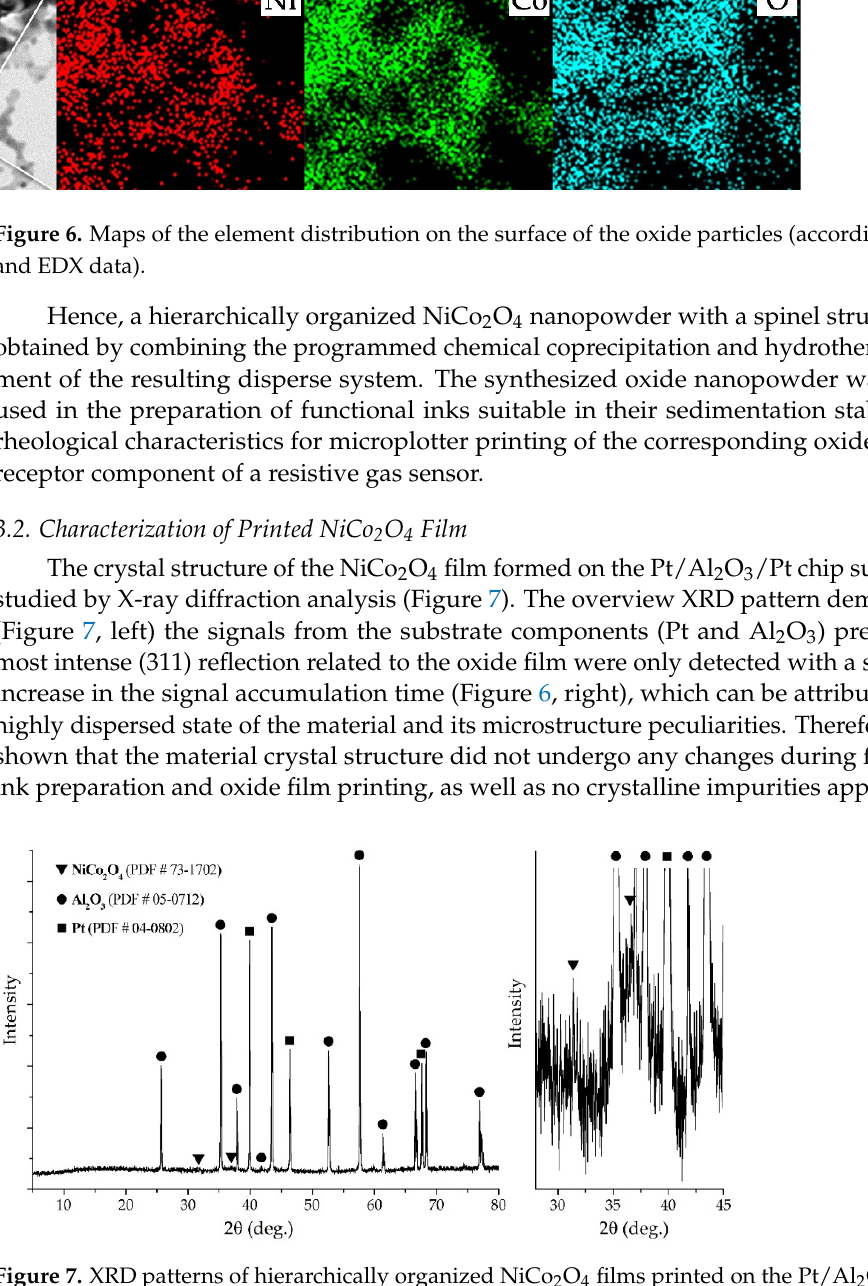
Figure 7. XRD patterns of hierarchically organized NiCo 2 O 4 films printed on the Pt/Al 2 O 3 /Pt chip surface (left: 5°–80°, signal accumulation time of 0.3 s; right: 28°–45°, 2.0 s).